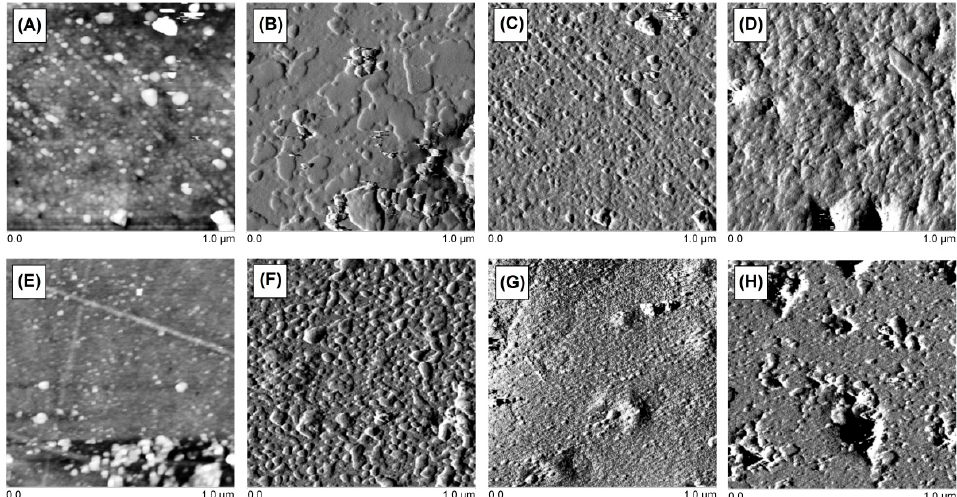
Figure 14. AFM photos of obtained blends: BPA.GDA + MMA ( A ), BPA.GDA + MMA + 1% PC ( B ), BPA.GDA + MMA + 5% PC ( C ), BPA.GDA + MMA + 10% PC ( D ), EGDMA + MMA ( E ), EGDMA + MMA + 1% PC ( F ), EGDMA + MMA + 5% PC ( G ) and EGDMA + MMA + 10% PC ( H ).